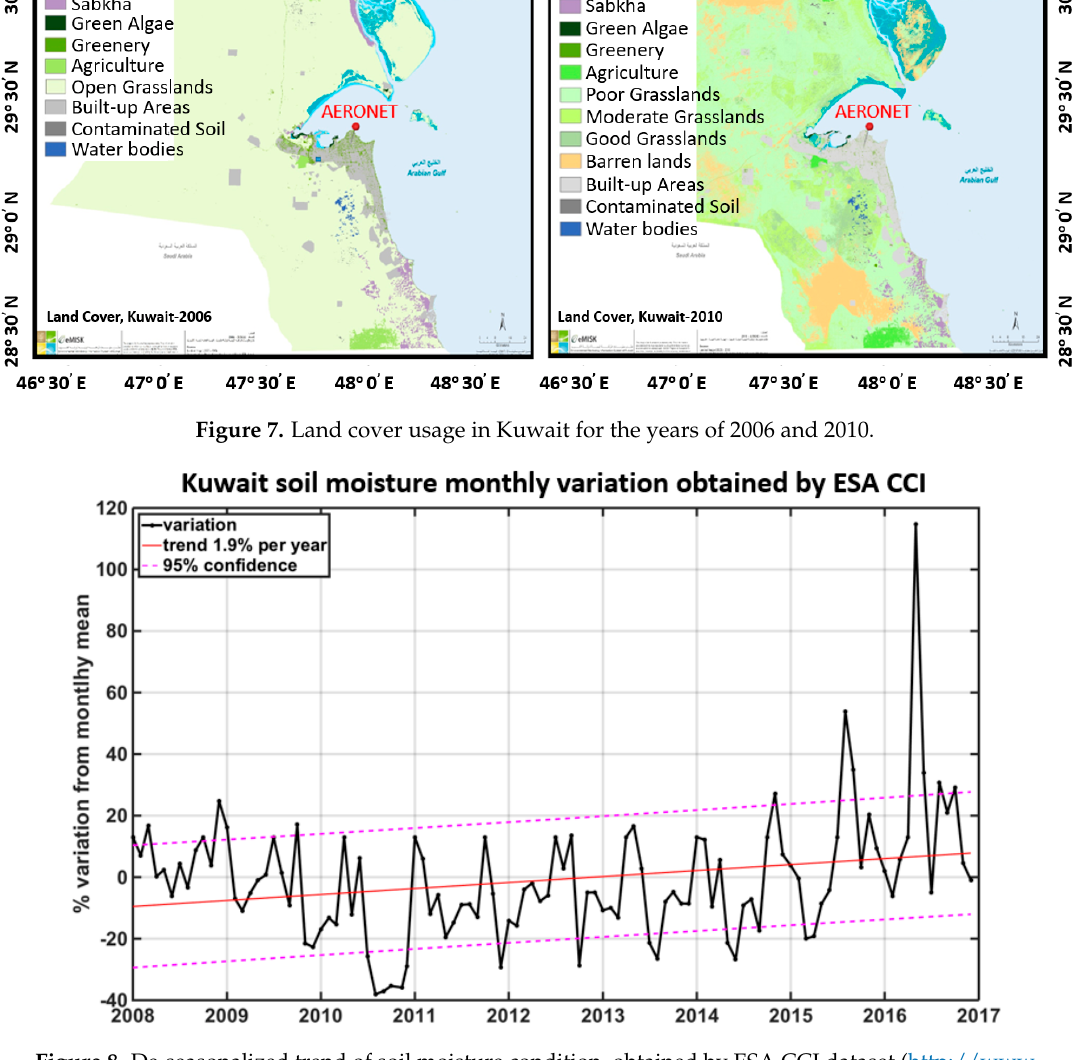
Figure 8. De-seasonalized trend of soil moisture condition, obtained by ESA CCI dataset (http://www.esa-soilmoisture-cci.org), for the time period 2006 2016.